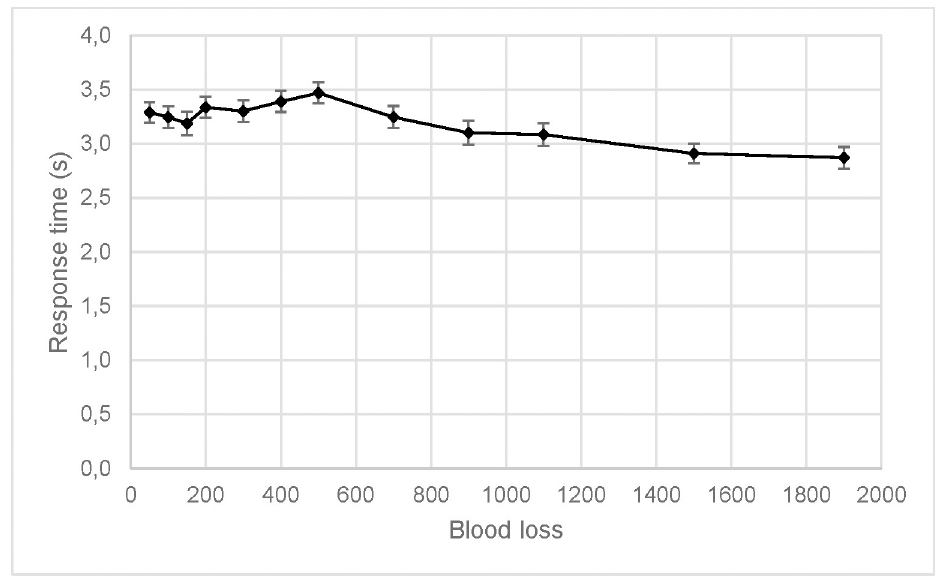
Fig 5. Response time over blood loss volume. The black line shows the mean response time, with 95% CI as error bars.